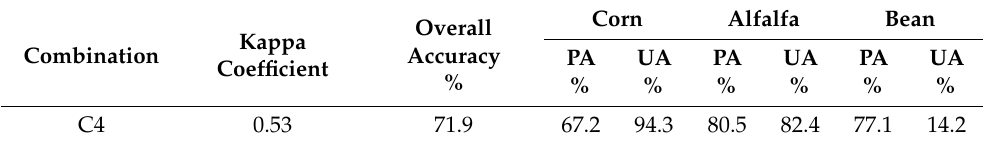
Table 10. Results of the classification on 6 May in the 2020 agricultural cycle.